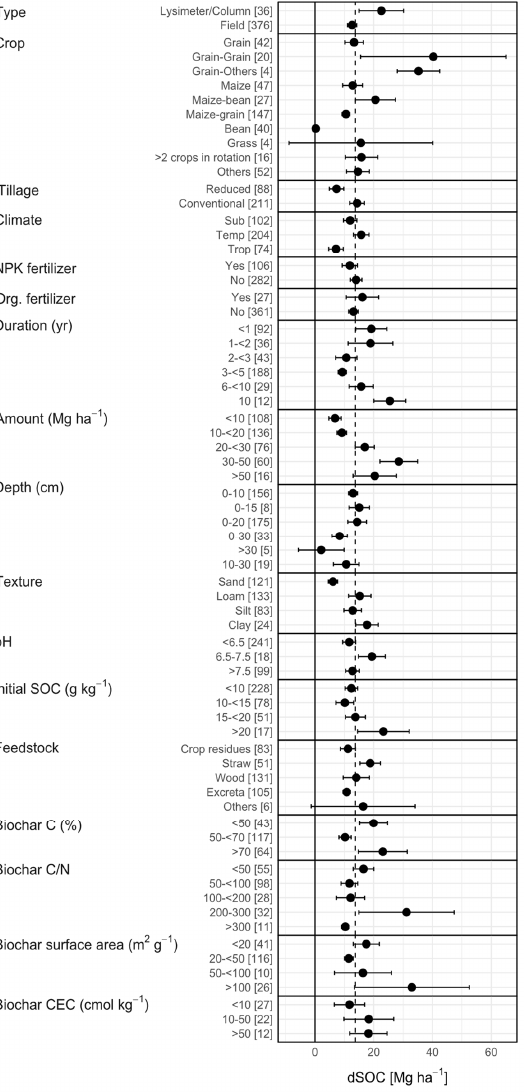
Figure 1. Meta-analysis results of the “field-dataset”, given as a forest plot. Presented is the mean difference of soil organic carbon stocks after biochar application (dSOC) influenced by different data groups. Number in brackets represent the number of included treatments. Points within the range represent the mean dSOC and the line within the 95% confidence interval represents the range of the effect size. If the effect size range crosses the “zero-effect-line”, given as a solid vertical line at 0%, the result can be interpreted as statistically insignificant. The effect sizes of each group were considered to be significantly different at p < 0.05 from each other if the 95% confidence intervals were not overlapping. The vertical dotted line represents the grand overall